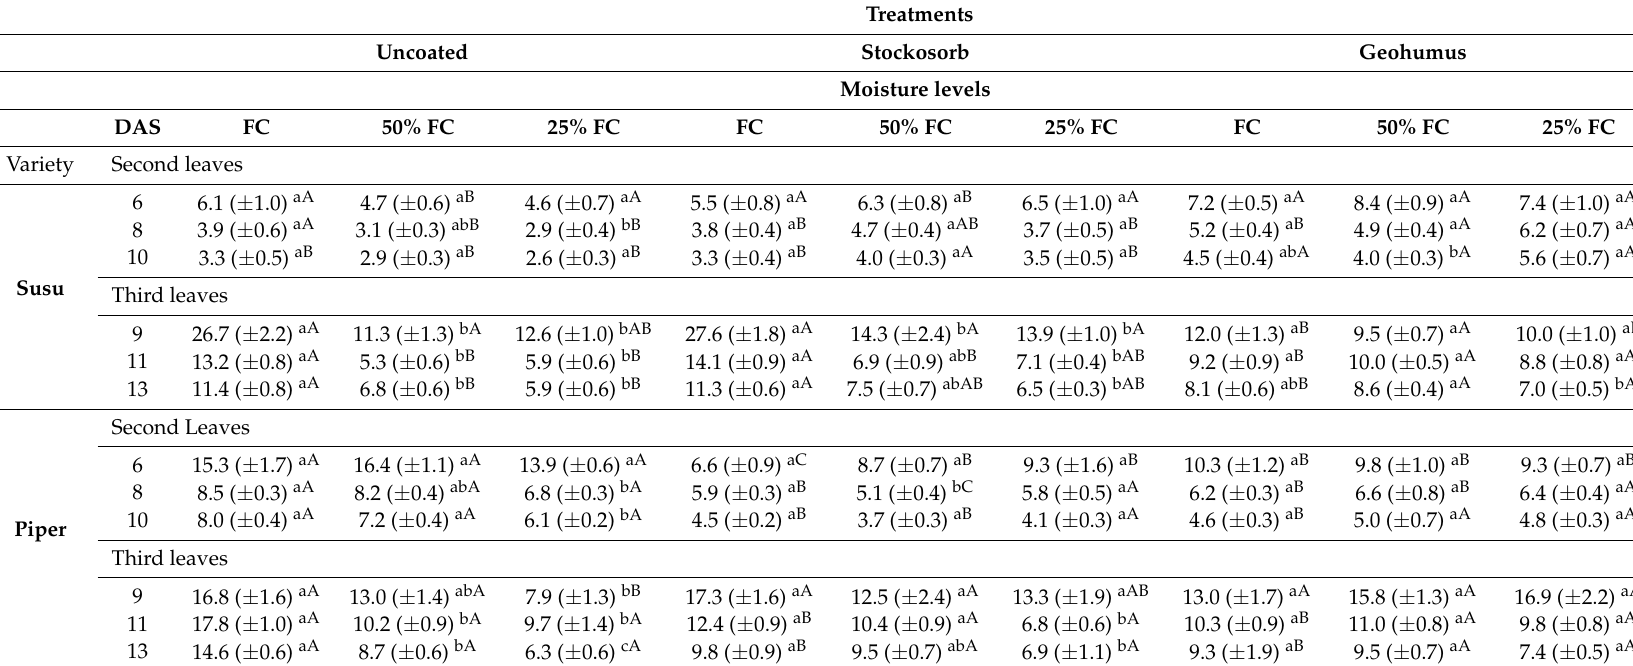
Table 1. Second and third leaf elongation rates (mm day − 1 ) of Susu and Piper seedlings at different moisture levels. Small and capital letters represents comparison in rates between moisture levels (rows) and comparisons between cereals at the same moisture level for a given day after sowing (DAS) respectively at alpha = 5%. Values in brackets are standard